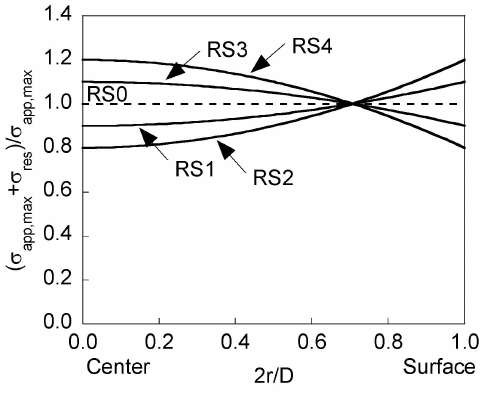
Figure 1. Stress profiles in cold drawn pearlitic steels.